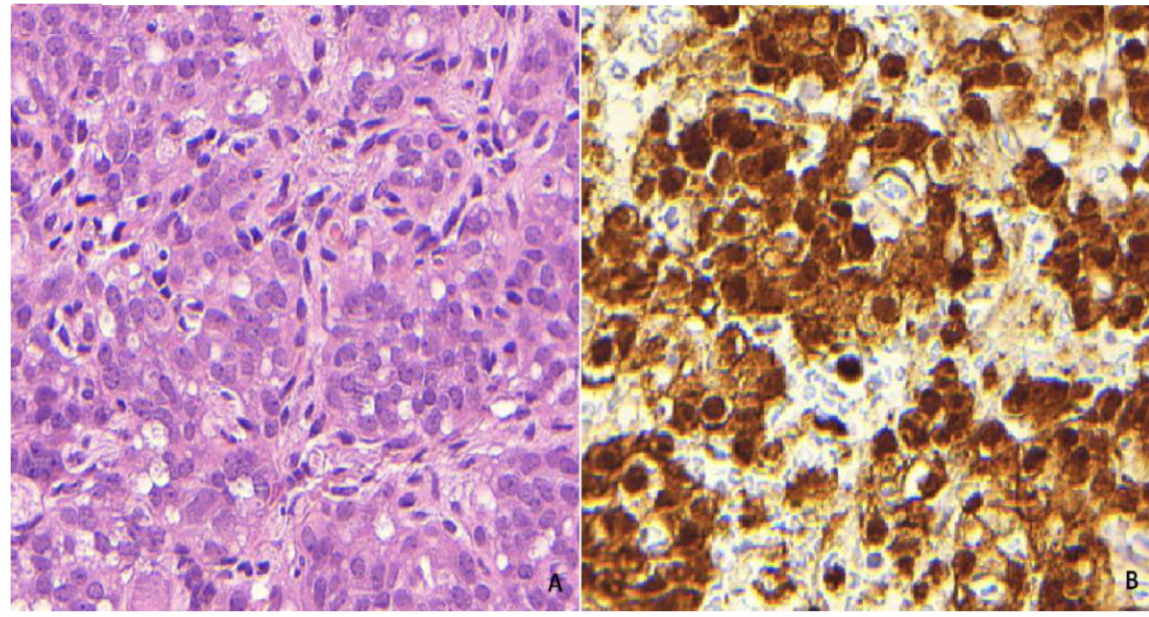
Figure 4. Solid pseudopapillary neoplasm immunohistochemical study. ( A ) Neoplasm composed of non-cohesive monomorphic cells in a solid pattern, with fibrovascular stroma (HE); ( B ) positive nuclear and cytoplasmic immunoexpression for β